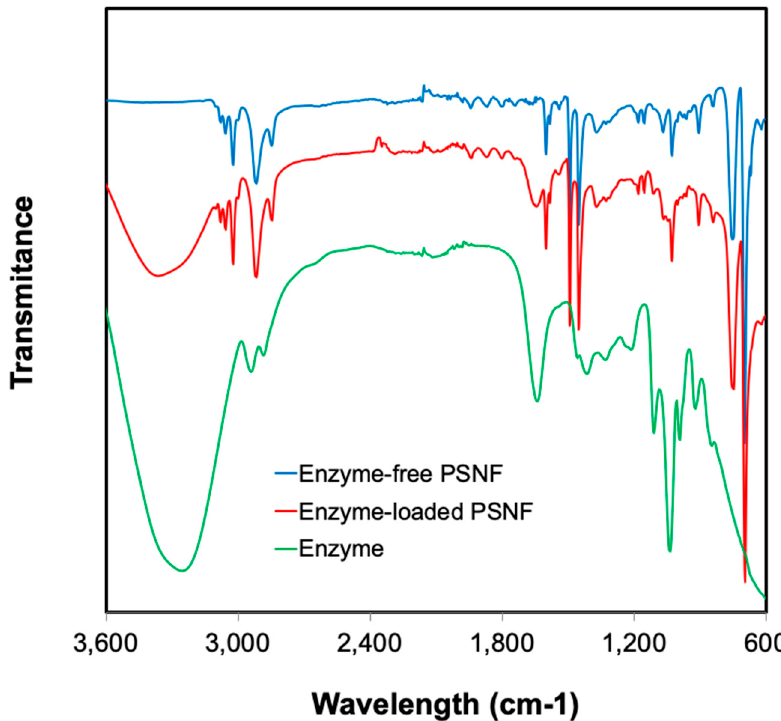
Figure 3. FTIR spectra of enzyme-free PSNF, enzyme-loaded PSNF and free β -enzyme.